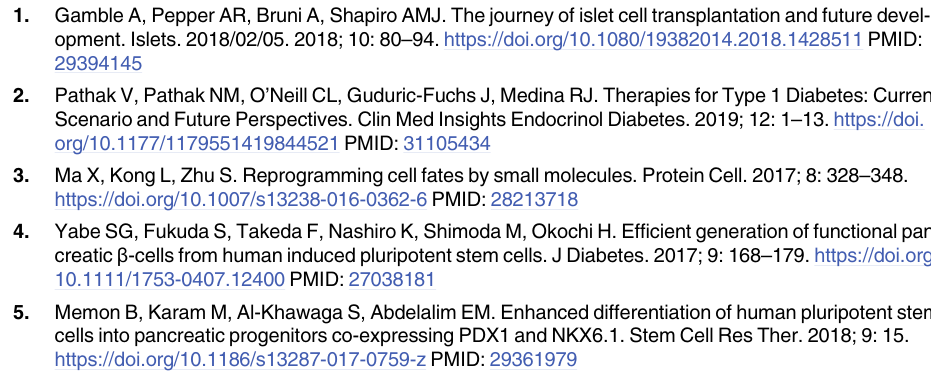
S5 Fig. Validation of our method in another cell line, TKDN4m. ( A ) Immunohistochemis- try of the cells. The expression of glucagon (green) and C-peptide (red). DAPI staining shown in blue. Scale bar: 100 μ m. ( B ) qRT-PCR analysis of the expression of Insulin (black) and Glu- cagon (white). ( C ) Flow cytometry analysis of C-peptide and glucagon expressing